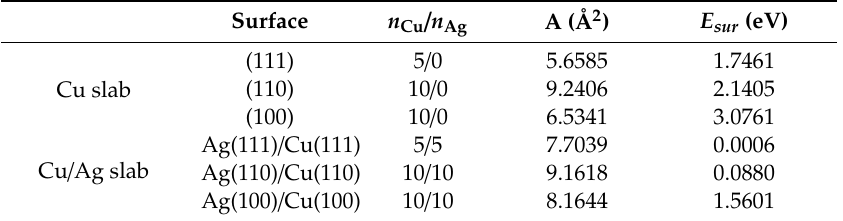
Table 4. The surface properties of slab models.